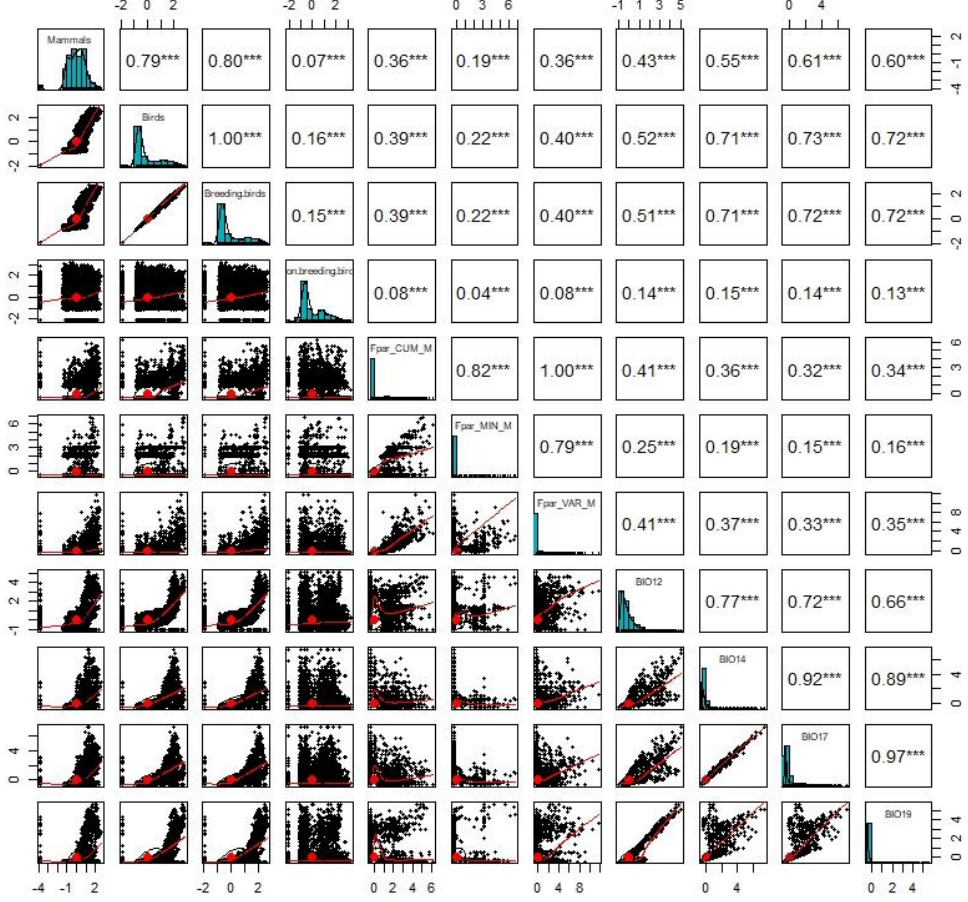
Figure 8. Pairs of the Spearman correlations of all MODIS FPAR-based DHIs and the four Bioclim variables (BIO12, BIO14, BIO17 and BIO19) versus the species richness of the four taxa (mammals, birds, breeding birds and non-breeding birds). Significant relations: *** p < 0.001.